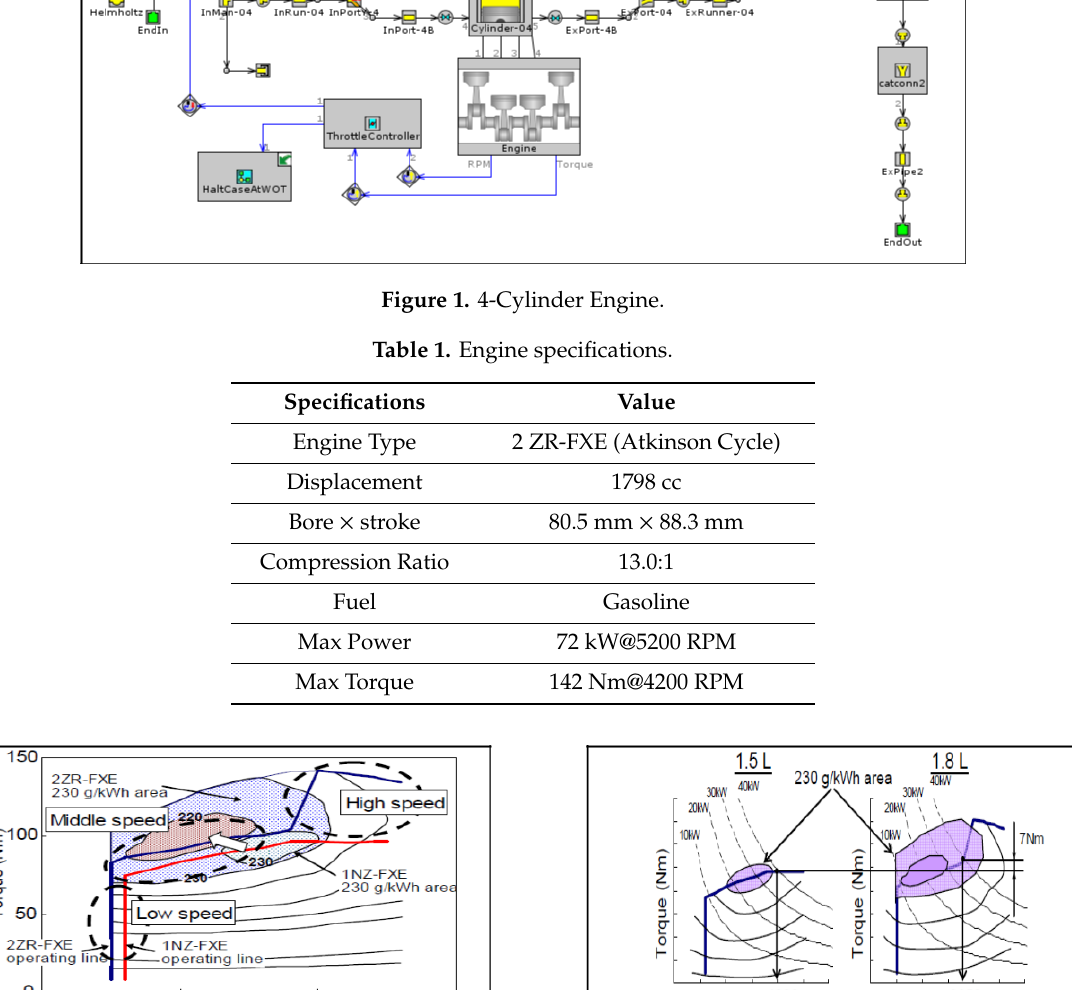
Figure 2. Theoretical BSFC map of 2 ZR-FXE Engine ( left ) and theoretical engine power of 2 ZR-FXE Engine ( right ).